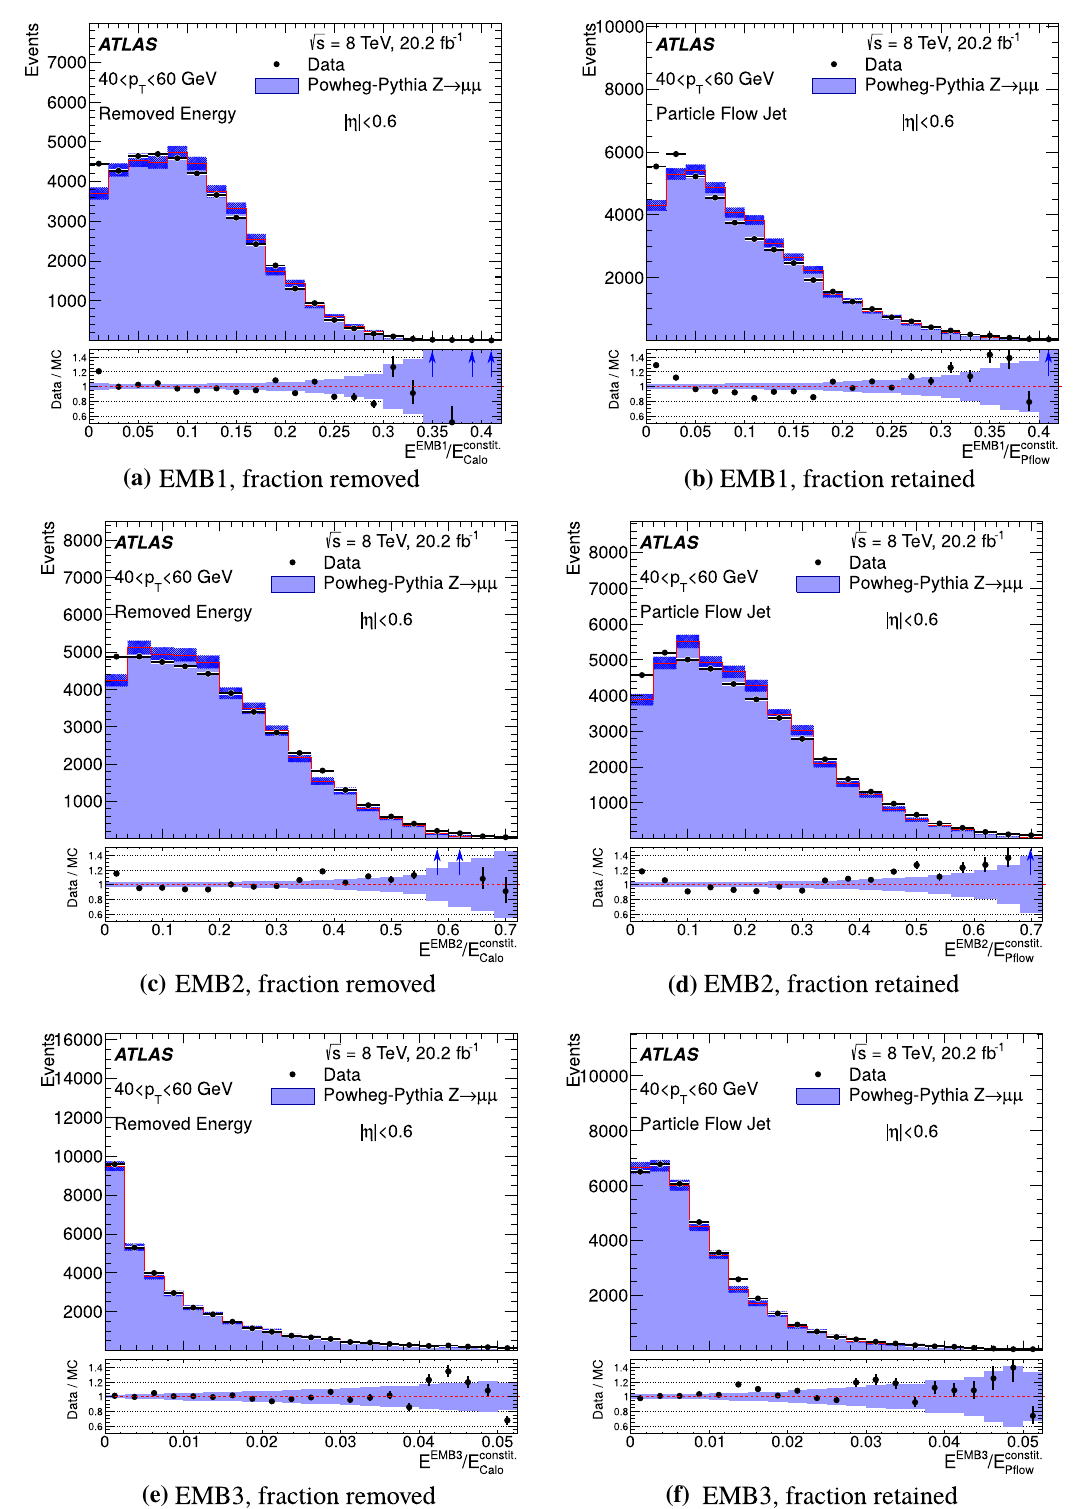
Fig. 35 Comparison of the fractions of jet energy removed from a sin- ers of the EM barrel, for a selection of jets with 40 < p T < 60GeV and | η | < 0 . 6, selected in Z → μμ events from collision data and MC sim- gle layer of the electromagnetic calorimeter relative to the total energy of the constituents of the matched calorimeter jet E constit. ulation. The simulated samples are normalised to the number of events ( left ) and Calo in data. The darker shaded bands represent the statistical retained relative to the total energy of the constituents of the particle flowjet E constit. ( right )bythecellsubtractionalgorithmindifferentlay- Pflow